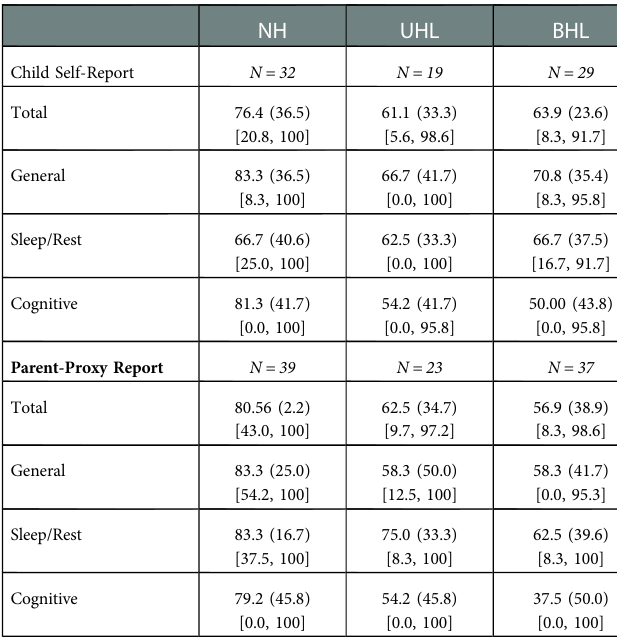
Figure S1A with a mean difference of PedsQL-MFS Total score of TABLE 2 Medians (interquartile range) and [min, max] of child self-report and parent-proxy report scores from the